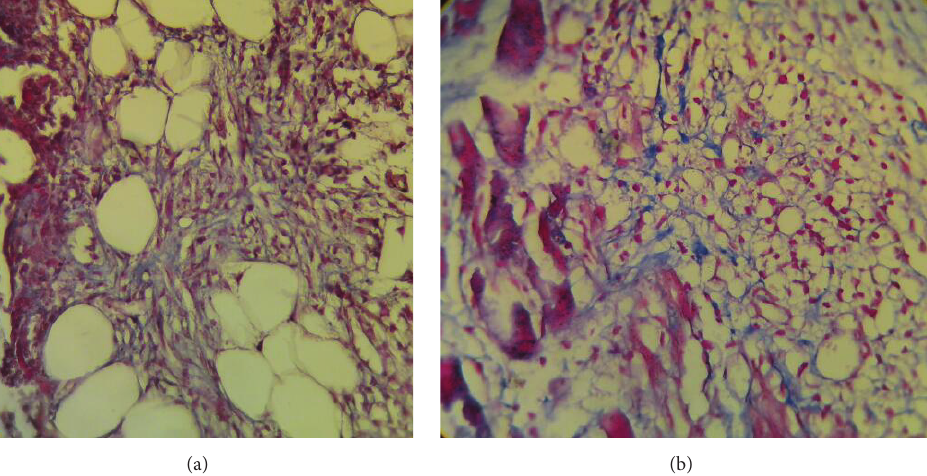
Figure 2: Photomicrographs of skin in emu oil (a) and control (b) groups in the 7th day. High active fibroblasts and collagen fibers in Emu oil treated group in comparison with the control group. Staining: Trichrome-Mallory, magnification: